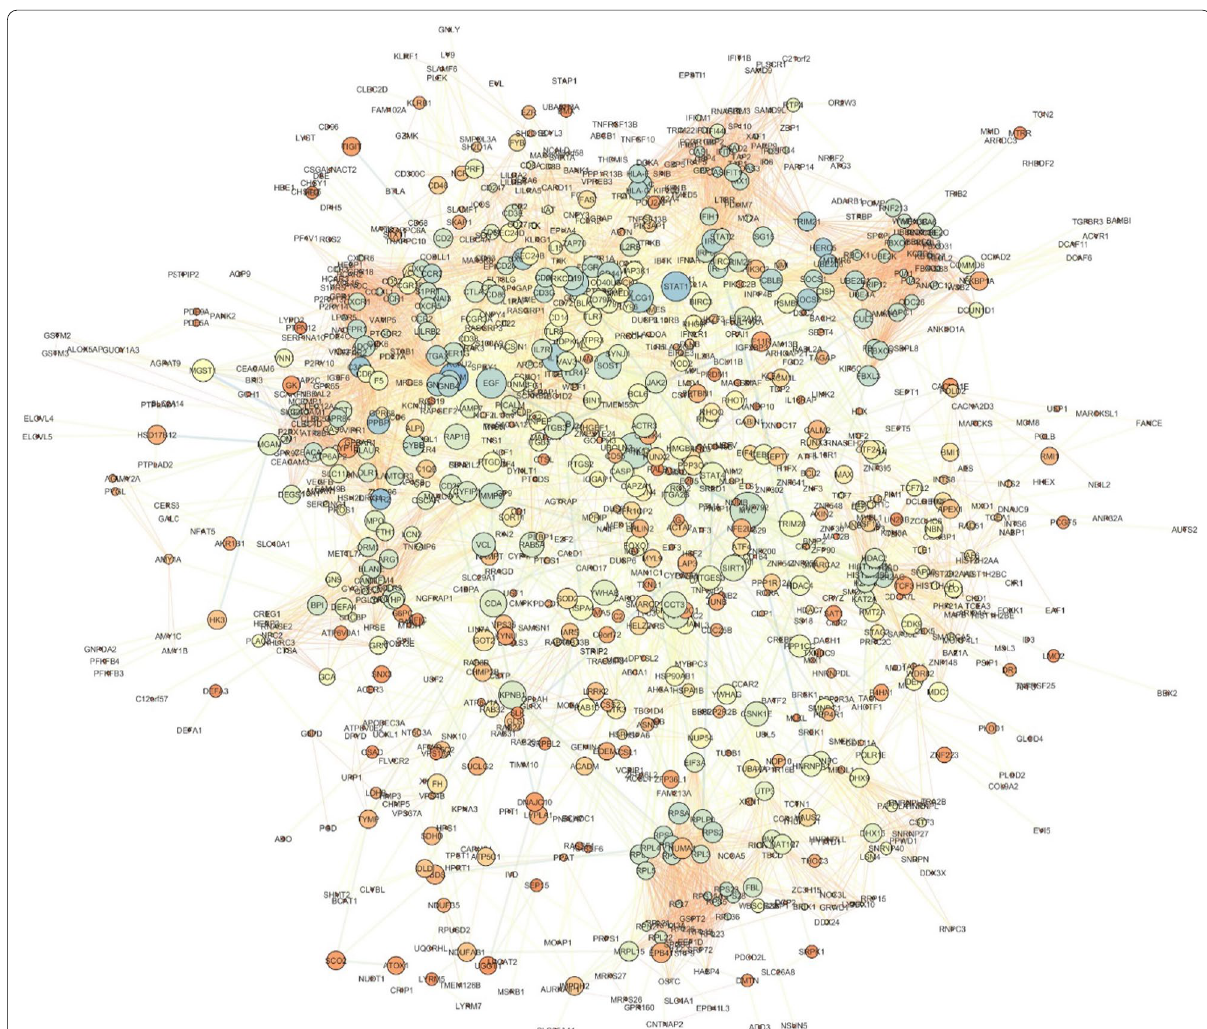
Fig. 3 Topology of the giant network extracted from the extended network is the biggest component in the extended network. It consisted of 1058 nodes and 6672 edges. Key nodes in the giant network are highlighted in different colours (low value to bright colour). The size of the nodes corresponds to their BC values (low value to small size; low values are represented in orange colour and large value with blue